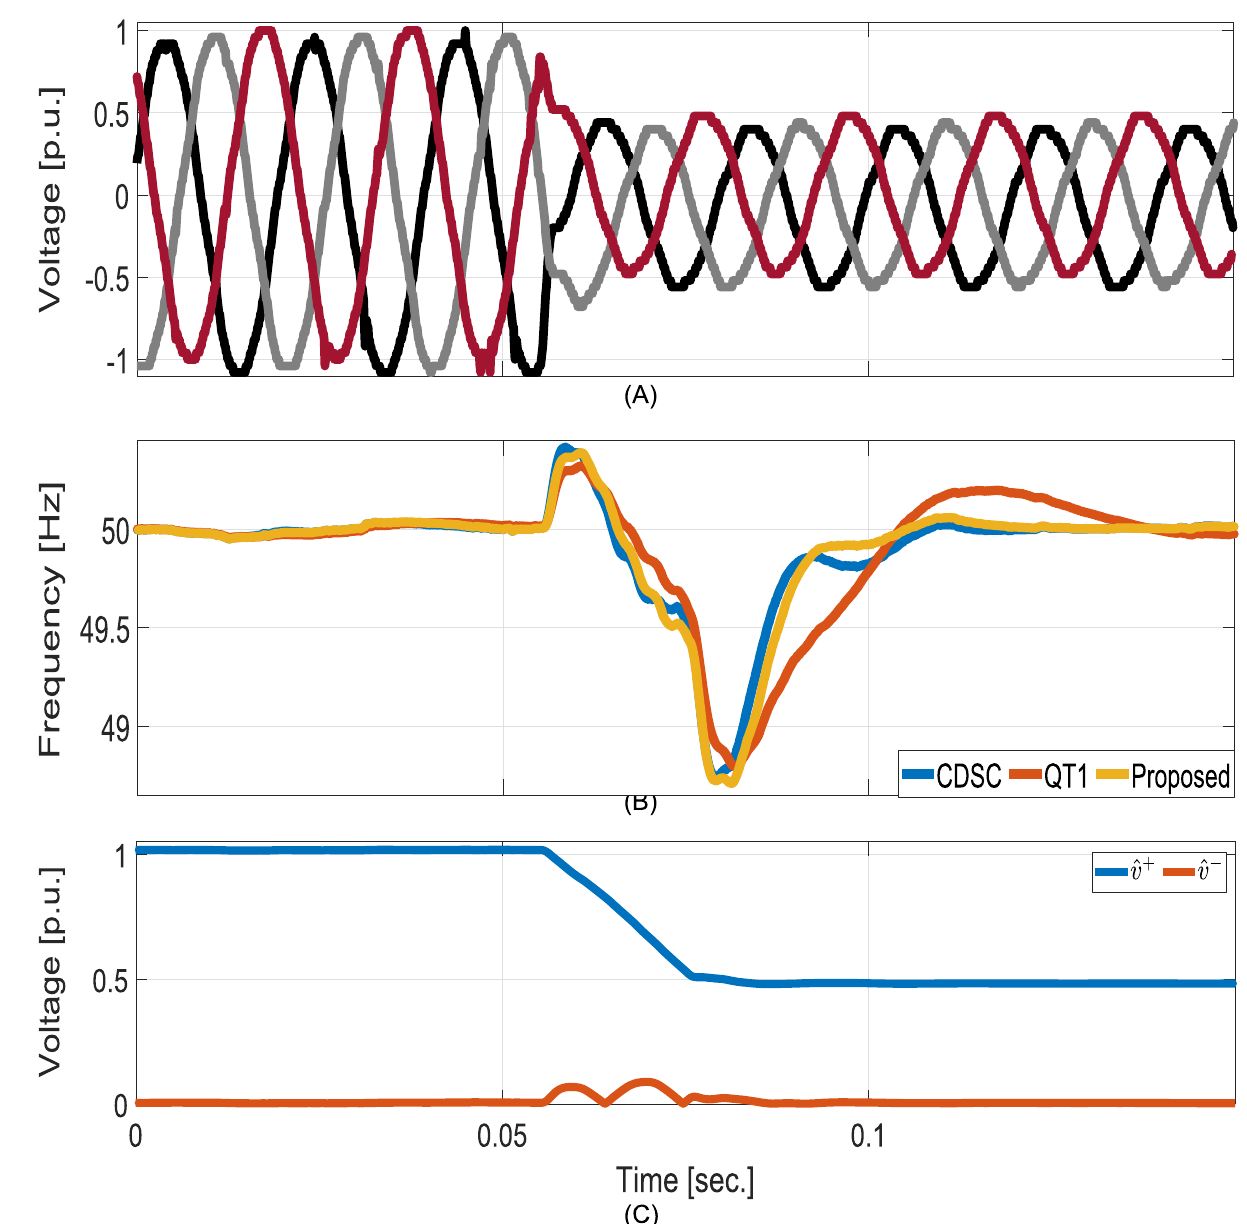
Fig 9. Comparative experimental results for voltage sag test. A: Grid voltages. B: Estimated frequencies. C: Estimated FFPS and FFNS amplitudes.